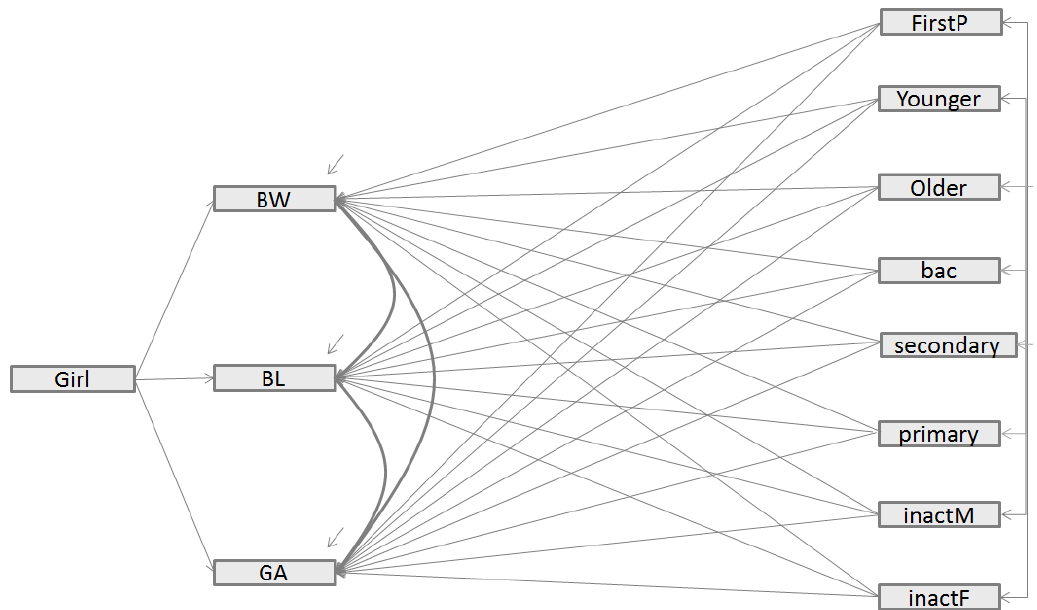
Figure 1. Structural equation model relating parents’ characteristics to those of an infant’s birth (BW, BL, GA) (Model 1)